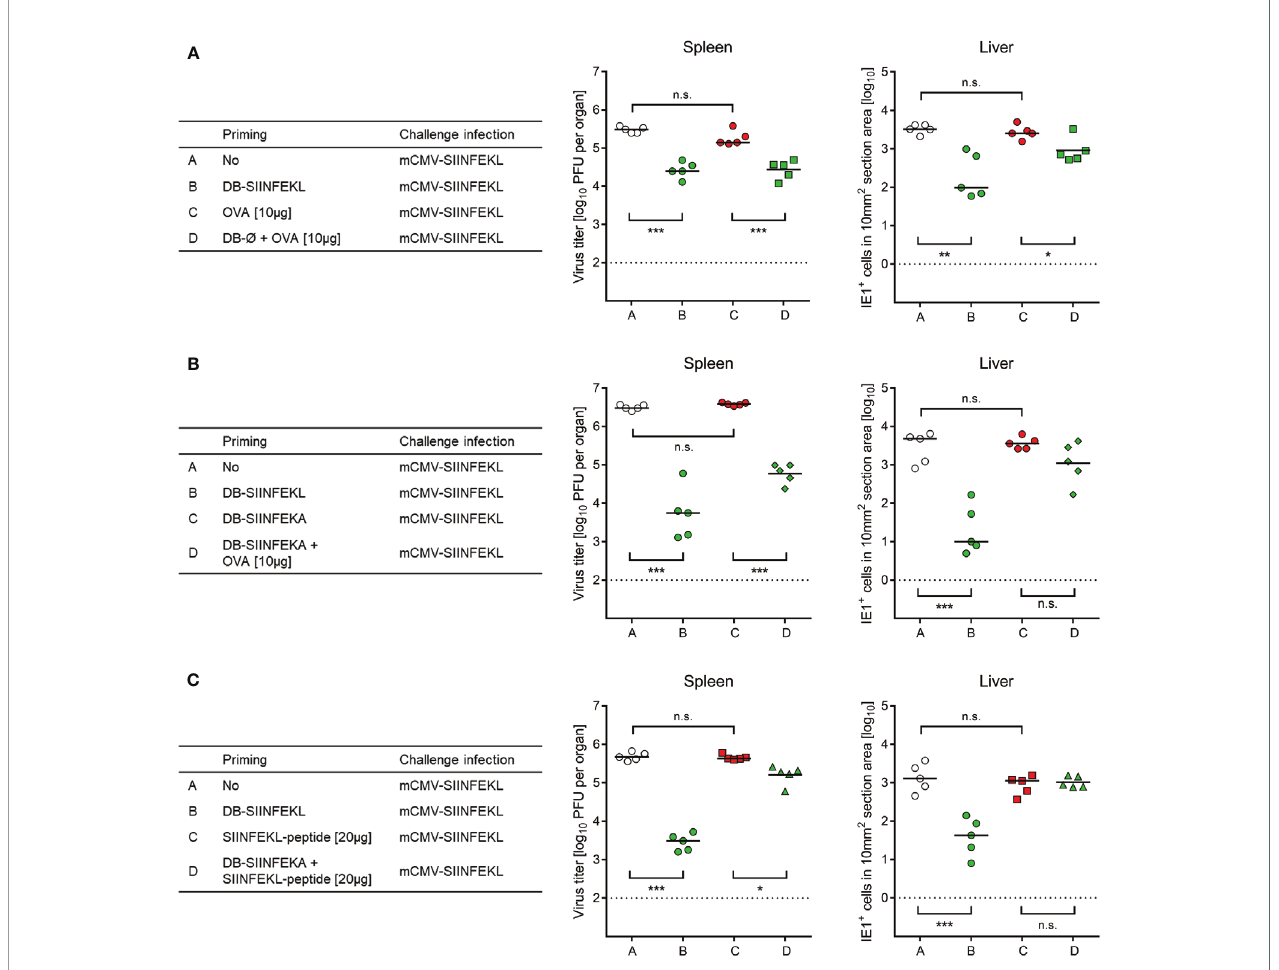
FIGURE 8 | Non-antigenic DBs facilitate priming of a protective response by OVA protein or SIINFEKL peptide. (A) Adjuvant role of unmodi fi ed DB (DB-Ø) for vaccination with OVA. (B) Adjuvant role of non-antigenic DB-SIINFEKA for vaccination with OVA. (C) Adjuvant role of non-antigenic DB-SIINFEKA for vaccination with peptide SIINFEKL. Symbols represent data from individually tested mice, with the median values marked. (Open circles), no vaccination. (Green symbols), SIINFEKL- speci fi c priming accomplished. (Red symbols), no SIINFEKL-speci fi c priming accomplished. Signi fi cance levels (*) P < 0.05, (**) P < 0.01, (***) P < 0.001, (n.s.), not signi fi cant ( P > 0.05). Dotted lines, detection limits of the